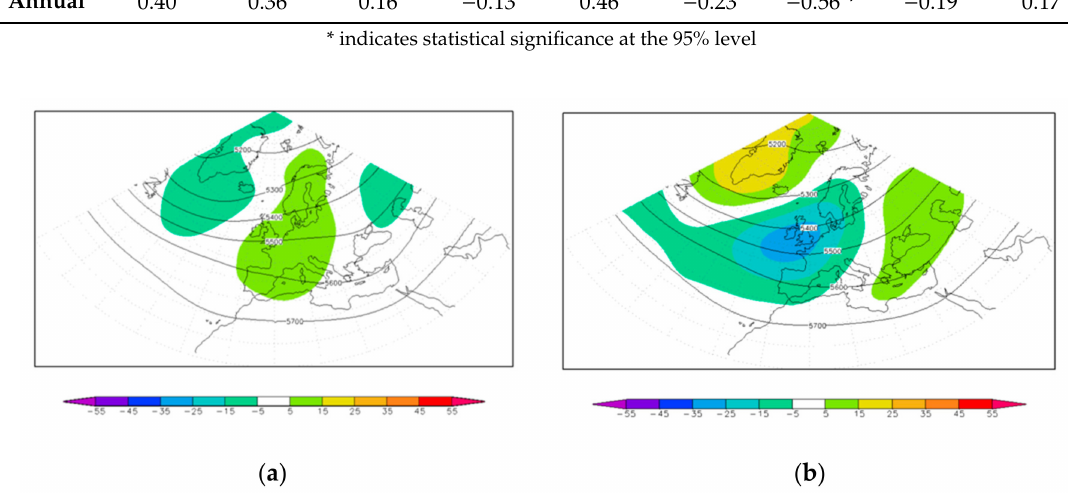
Figure 4. Covariance maps of the Z500 anomalies with the wind monthly anomalies index for the Calm regime ( a ) and for the S wind regime ( b ) over Emilia. Shading shows the covariance pattern, while contours (every 100 m) describe the full field associated with